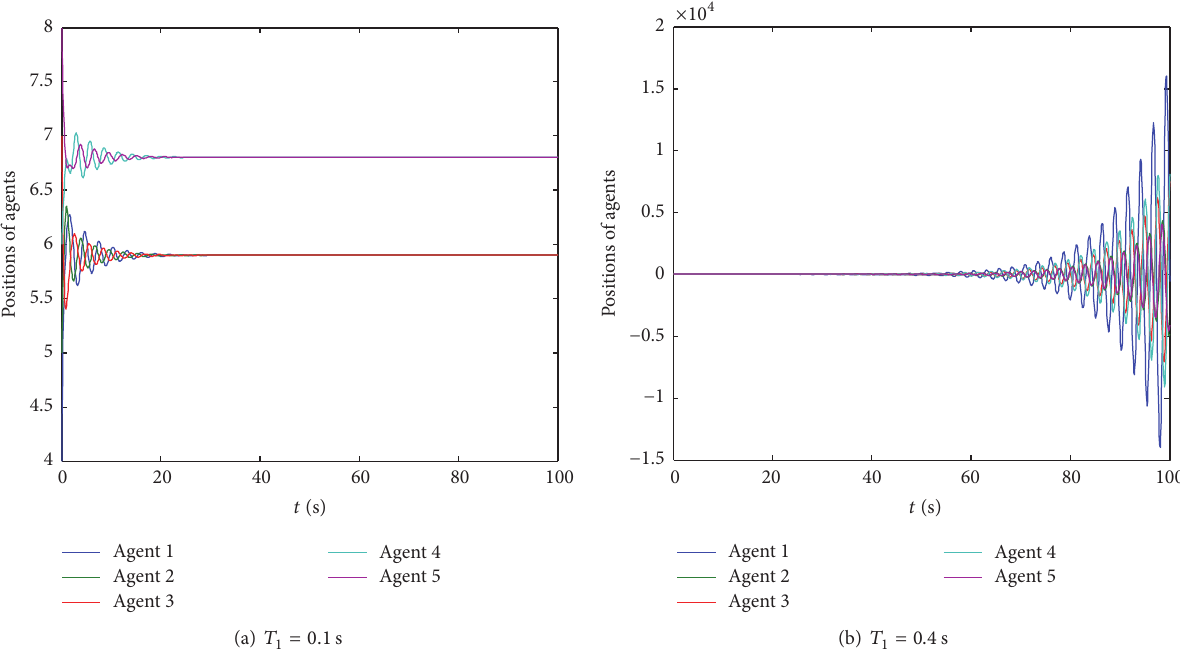
Figure 5: State trajectories of the agents in the networks